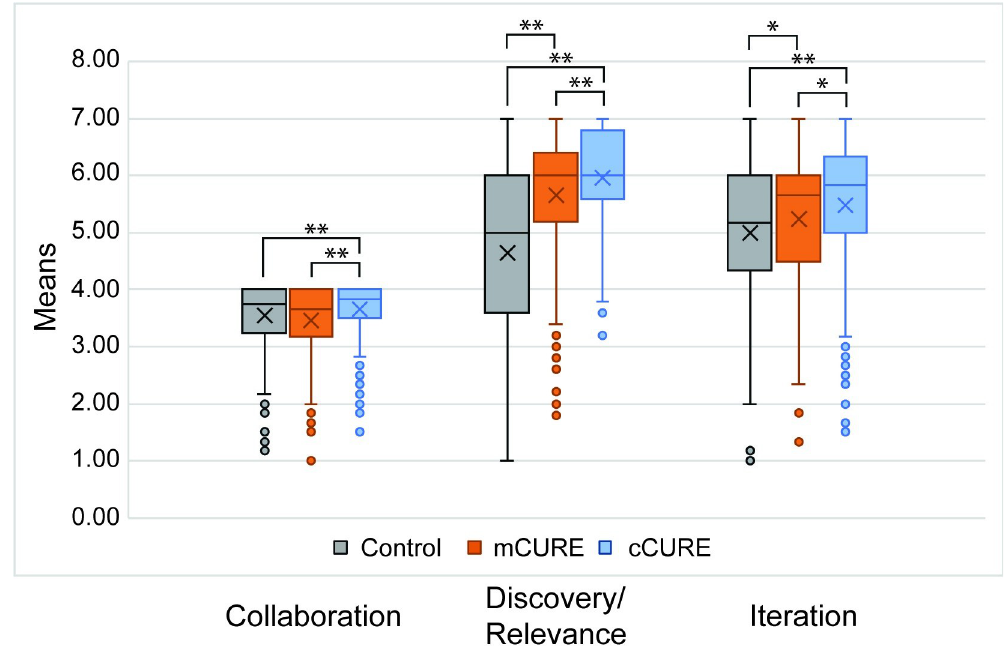
Fig 2. Students experience more CURE elements in cCUREs than mCUREs or control laboratories. Students reported their experiences with three elements of a CURE at the end of the semester. Collaboration was scored using 1 (Never), 2 (One or two times), 3 (Monthly), and 4 (Weekly). Iteration and discovery/relevance elements were scored 1 (Strongly Disagree) to 7 (Strongly Agree). An ANOVA indicates that iteration and discovery/relevance are significantly